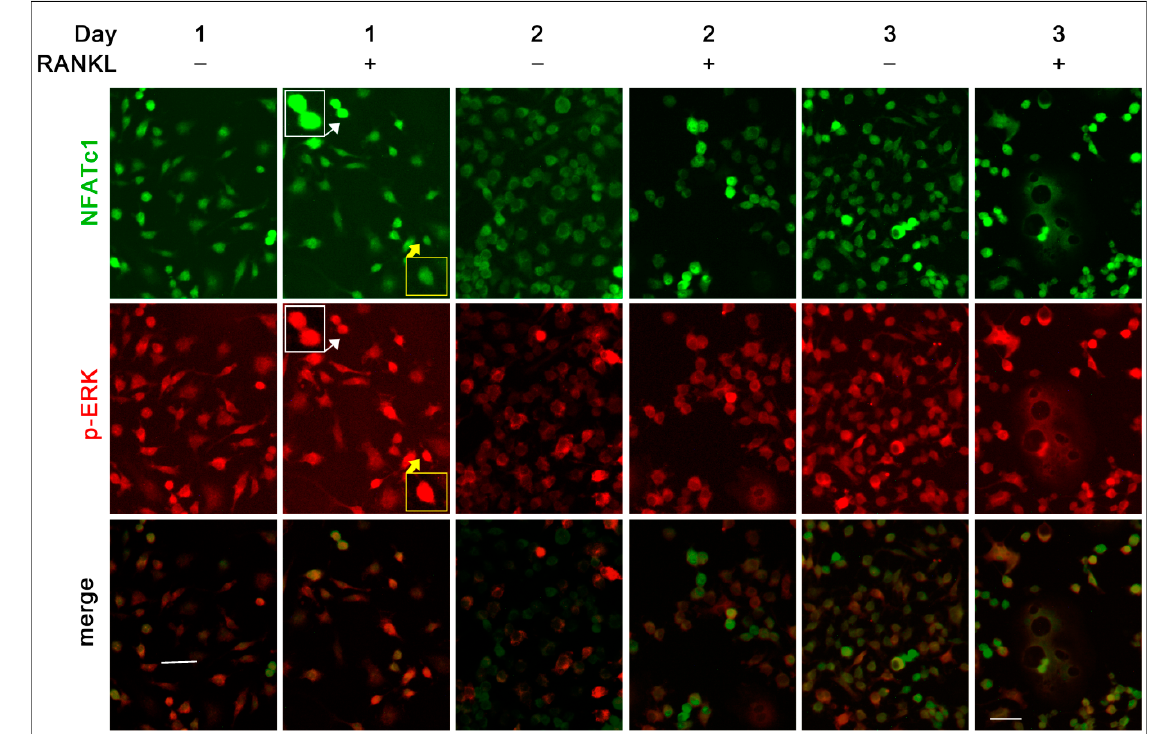
Figure 8. NFATc1 and p-ERK subcellular co-localization. Cells were cultured in the absence (RANKL − ) or in the presence of RANKL (RANKL + ) for 1, 2, and 3 days. Cells were stained with anti NFATc1 (green) and p-ERK (red) antibodies. White and yellow frames and arrows indicate 1.5 × magnification of p-ERK nuclear localization. White frame indicates 1.5 × magnification of NFATc1 and p-ERK co-localization. The data shown represent two independent experiments with comparable outcomes. Magnification 40 × . Scale bar of 50 µ